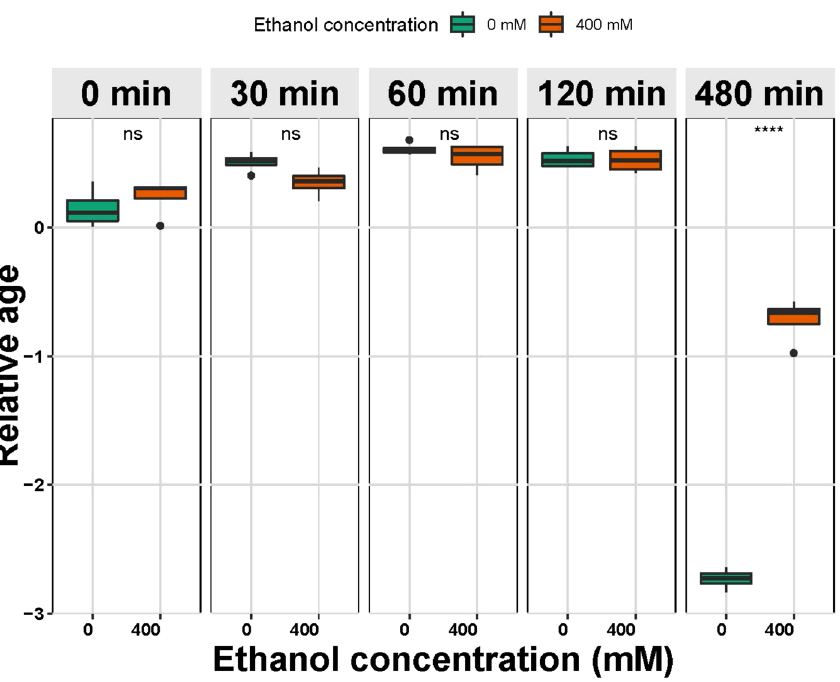
Figure 2. Effect of ethanol exposure on transcriptional time, presented as relative age. The relative age was computed by transforming the predicted ages (in hours) into the standard normal distribution. There was no significant difference in the “age” of animals due to ethanol exposure or to the treatment at 0, 30, 60, or 120 min of treatment. Animals undergoing the treatment for 480 min were significantly transcriptionally “younger” than animals treated for shorter times, although they were chronically 6–8 h older than the animals treated for shorter times. This suggests that this broad transcriptional delay is due to the food deprivation during the treatment. Ethanol exposure modified this transcriptional delay, suggesting that the animals are able to use ethanol as a calorie source, counteracting the starvation-induced effects on transcription. (one tailed t-test p <